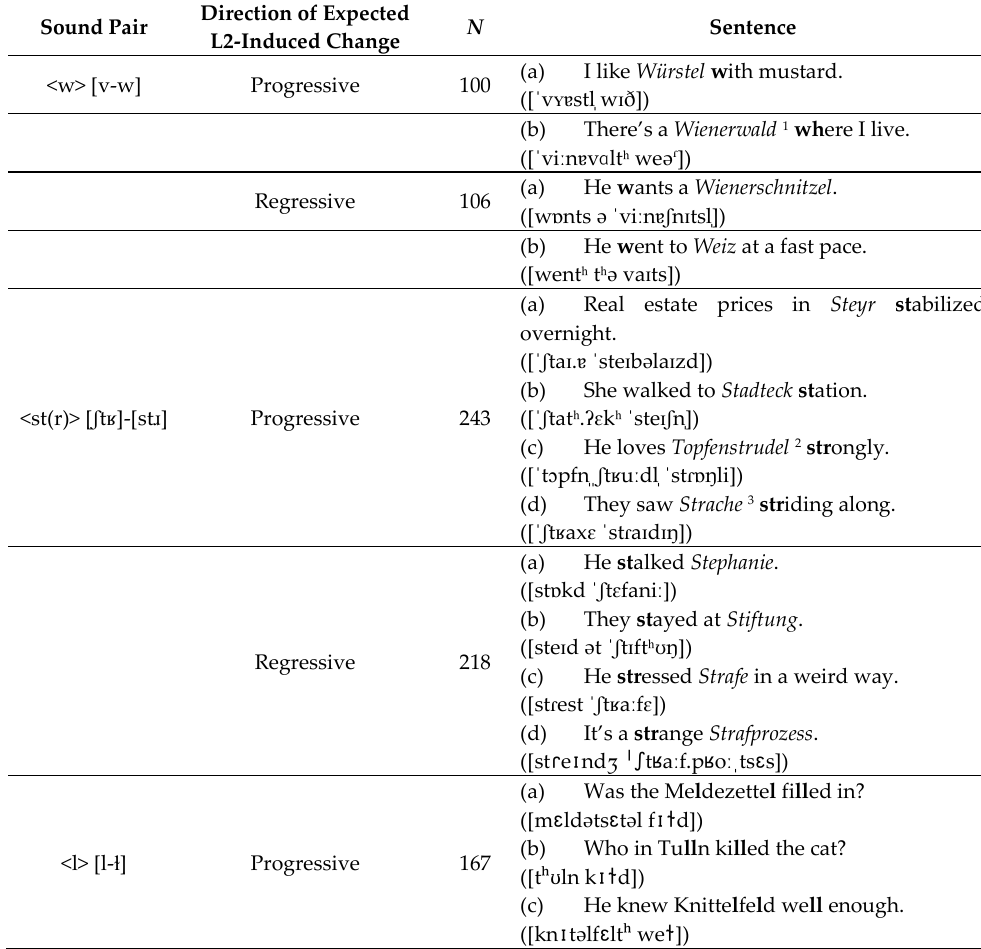
Table 2. Code-switching materials analyzed in this study.